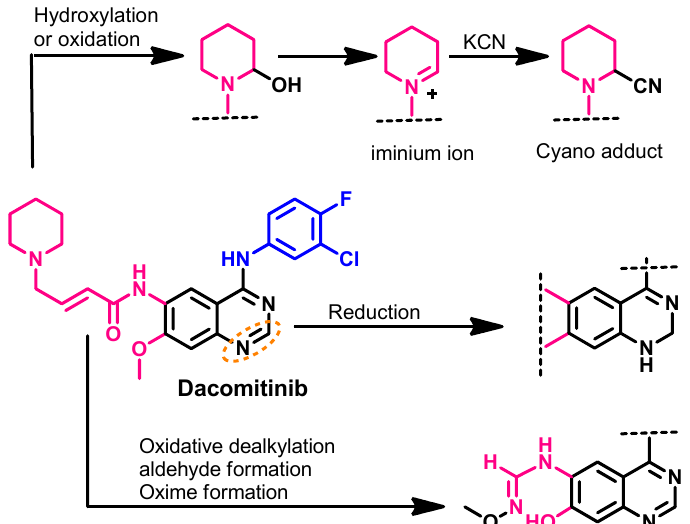
Figure 24. The proposed metabolic pathways of dacomitinib. The nitrile product is a KCN addition product that indicates the formation of the reactive iminium ion intermediate.